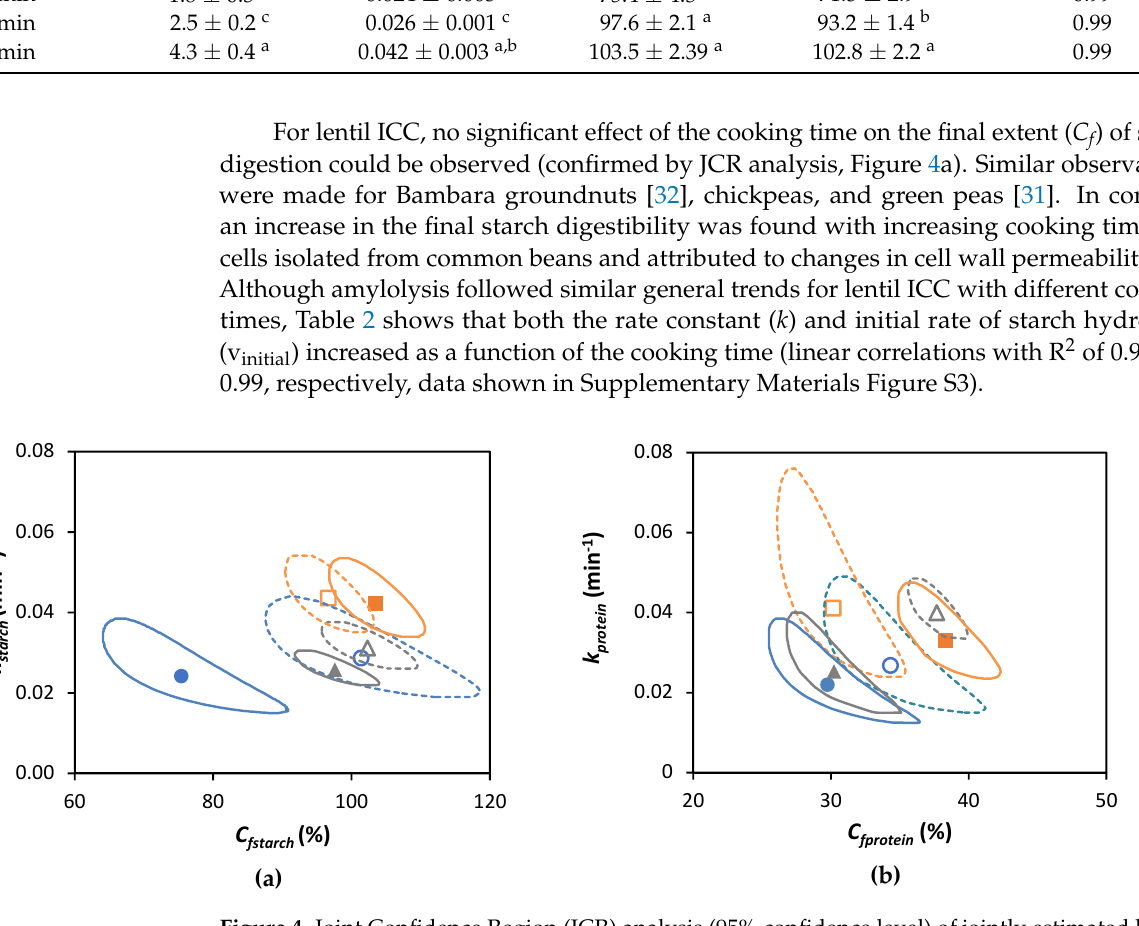
Figure 4: Joint confidence region (JCR ) analysis (95% confidence level) of Figure 4. Joint Confidence Region (JCR) analysis (95% confidence level) of jointly estimated kinetic jointly estimated kinetic parameters estimated using the fractional parameters estimated using the fractional conversion model (Equation (3)) for ( a ) in vitro conversion model (Eq. 3) for (a) in vitro amylolysis, and (b) in vitro proteolysis of cooked lentils ( ● , ▲ , and ■ ) and corresponding isolated cotyledon cells ( ○ , ∆ , □ ) cooked for 15, 30, or 60 minutes, respectively. Full and dotted lines represent JCR of whole cooked lentils and isolated cotyledon cells, respectively.